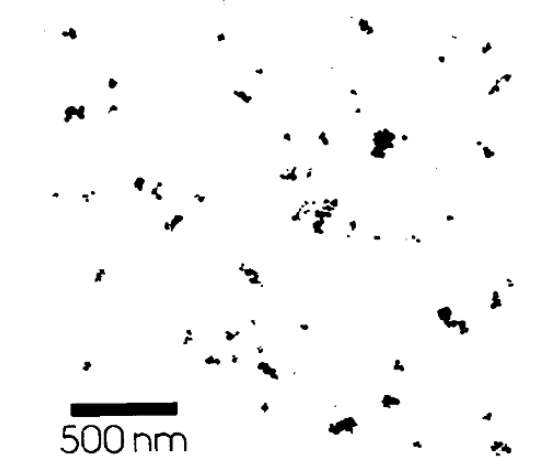
Figure 10. TEM image for the fractal dimension calculation in the carbon/polymer composite